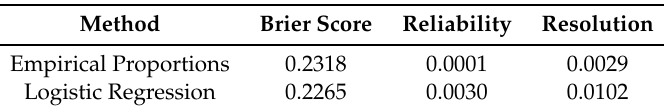
Table 1. Brier scores for probabilistic system length forecasts. The uncertainty component of the Brier score is 0.2337 in both cases.